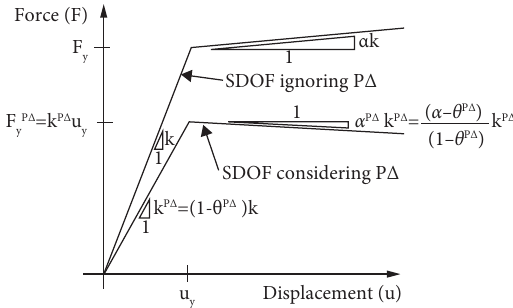
Figure 1: Modifcation of force-displacement curve for P- Δ efect (Wilkinson and Lavan [32]).